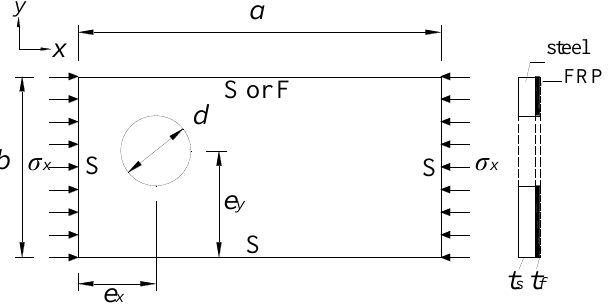
Figure 1. Geometry and Boundary conditions (BCs) of the perforated plates strengthened with fiber-reinforced polymers (FRP).